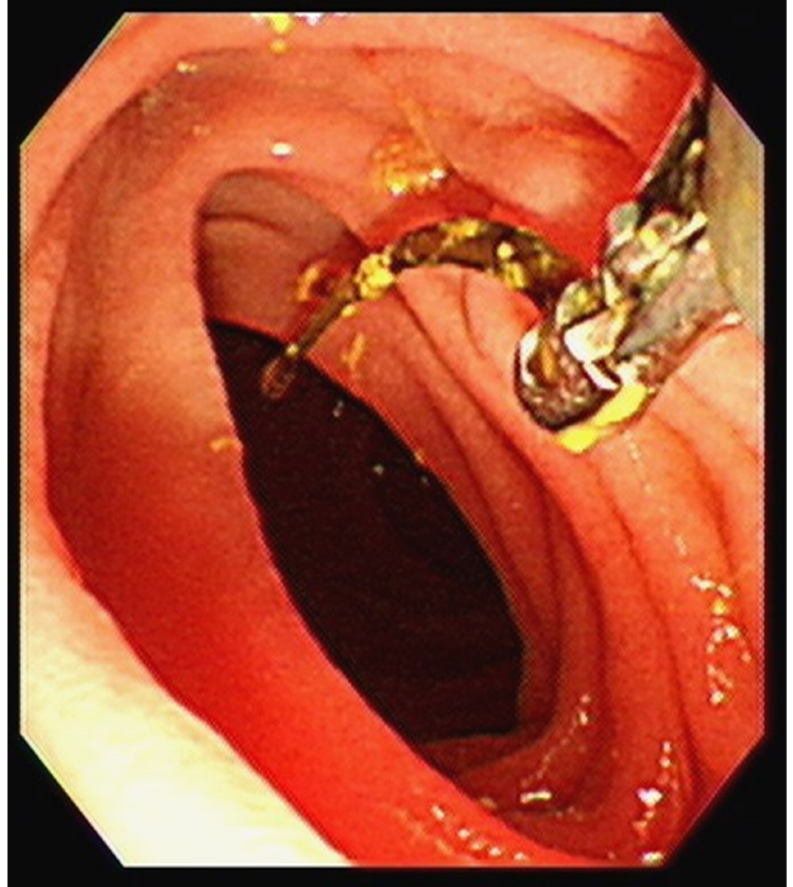
Figure 2. The patient underwent a biopsy, which revealed a 1.7 cm curved, linear, rusty, metallic surgical suture needle containing bile. A retained surgical item poses a hazard to surgical safety and